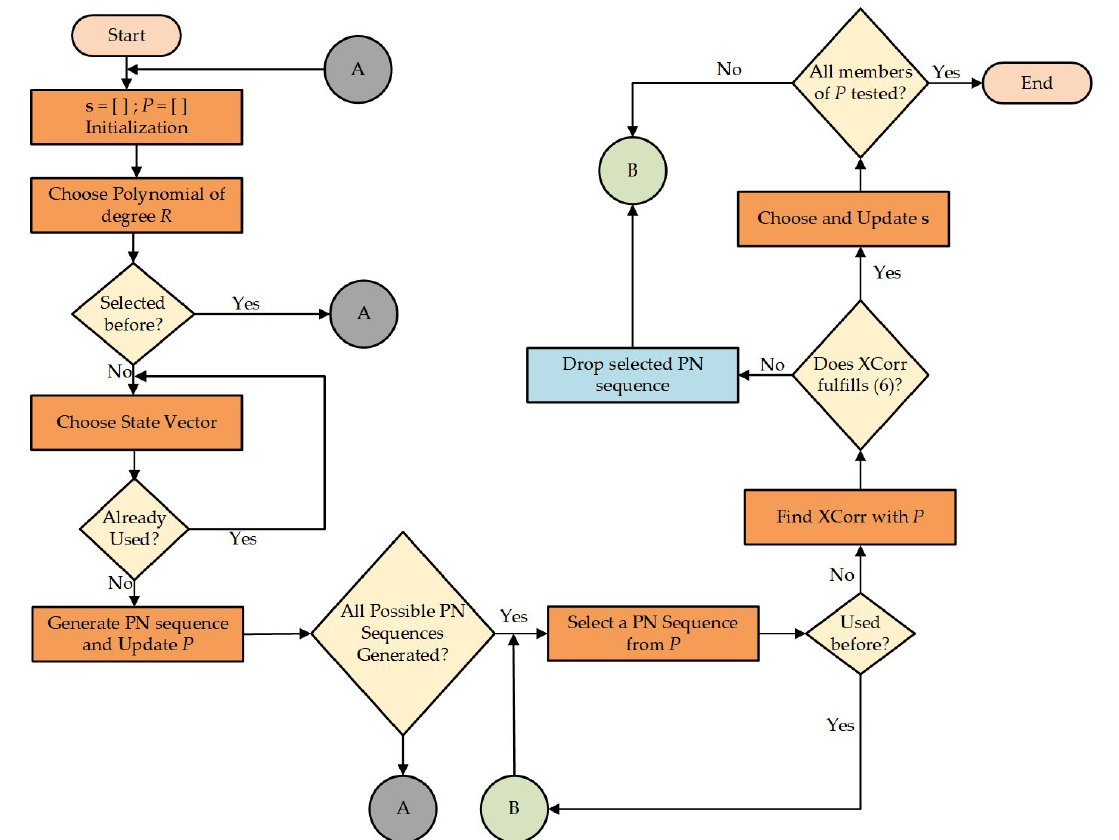
Figure 4. Novel GI sequence generation and selection for eOFDM